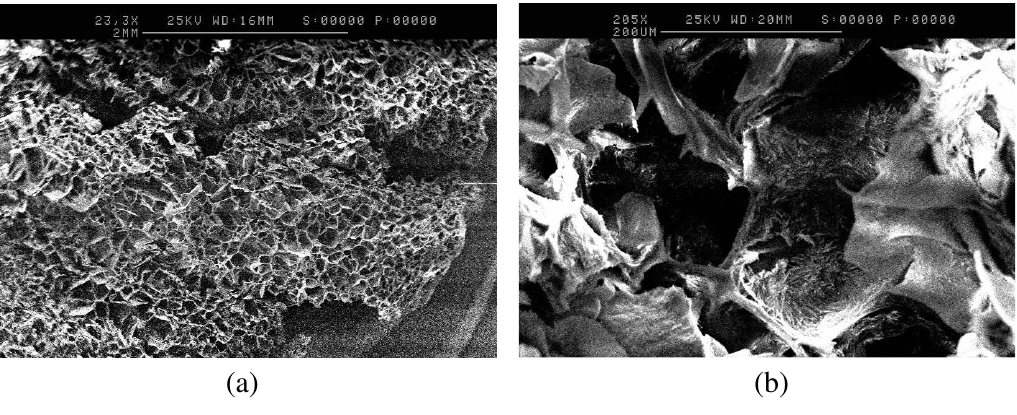
Figure 2. ( a ) SEM image of the tablet matrix of the formulation adjusted to pH 8. Horizontal Sample. Low Magnification, ×23; ( b ) SEM image of the tablet matrix of the formulation adjusted to pH 8. Horizontal Sample. High Magnification, ×205.